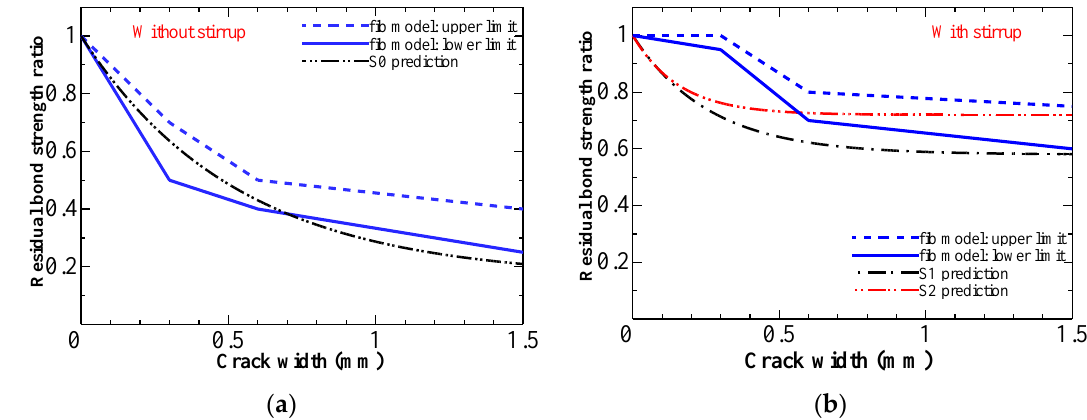
Figure 15. Comparison of the test results with the fib model: ( a ) specimen without stirrup; ( b ) specimen with stirrup.